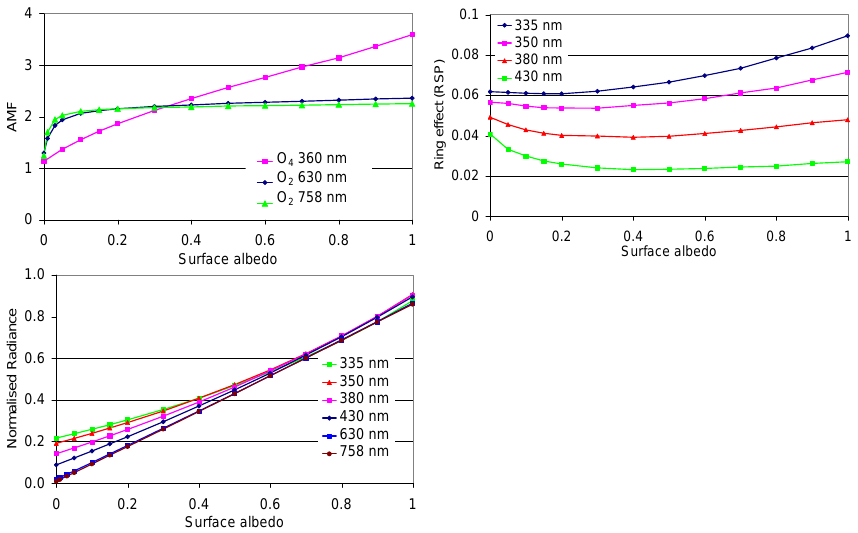
Fig. 10 Dependence of the Ring effect, the O 2 and O 4 absorption and the normalised radiance on the surface albedo. The calculations are performed for SZA of 30° and a viewing angle of -90° (nadir geometry) and no aerosols present.